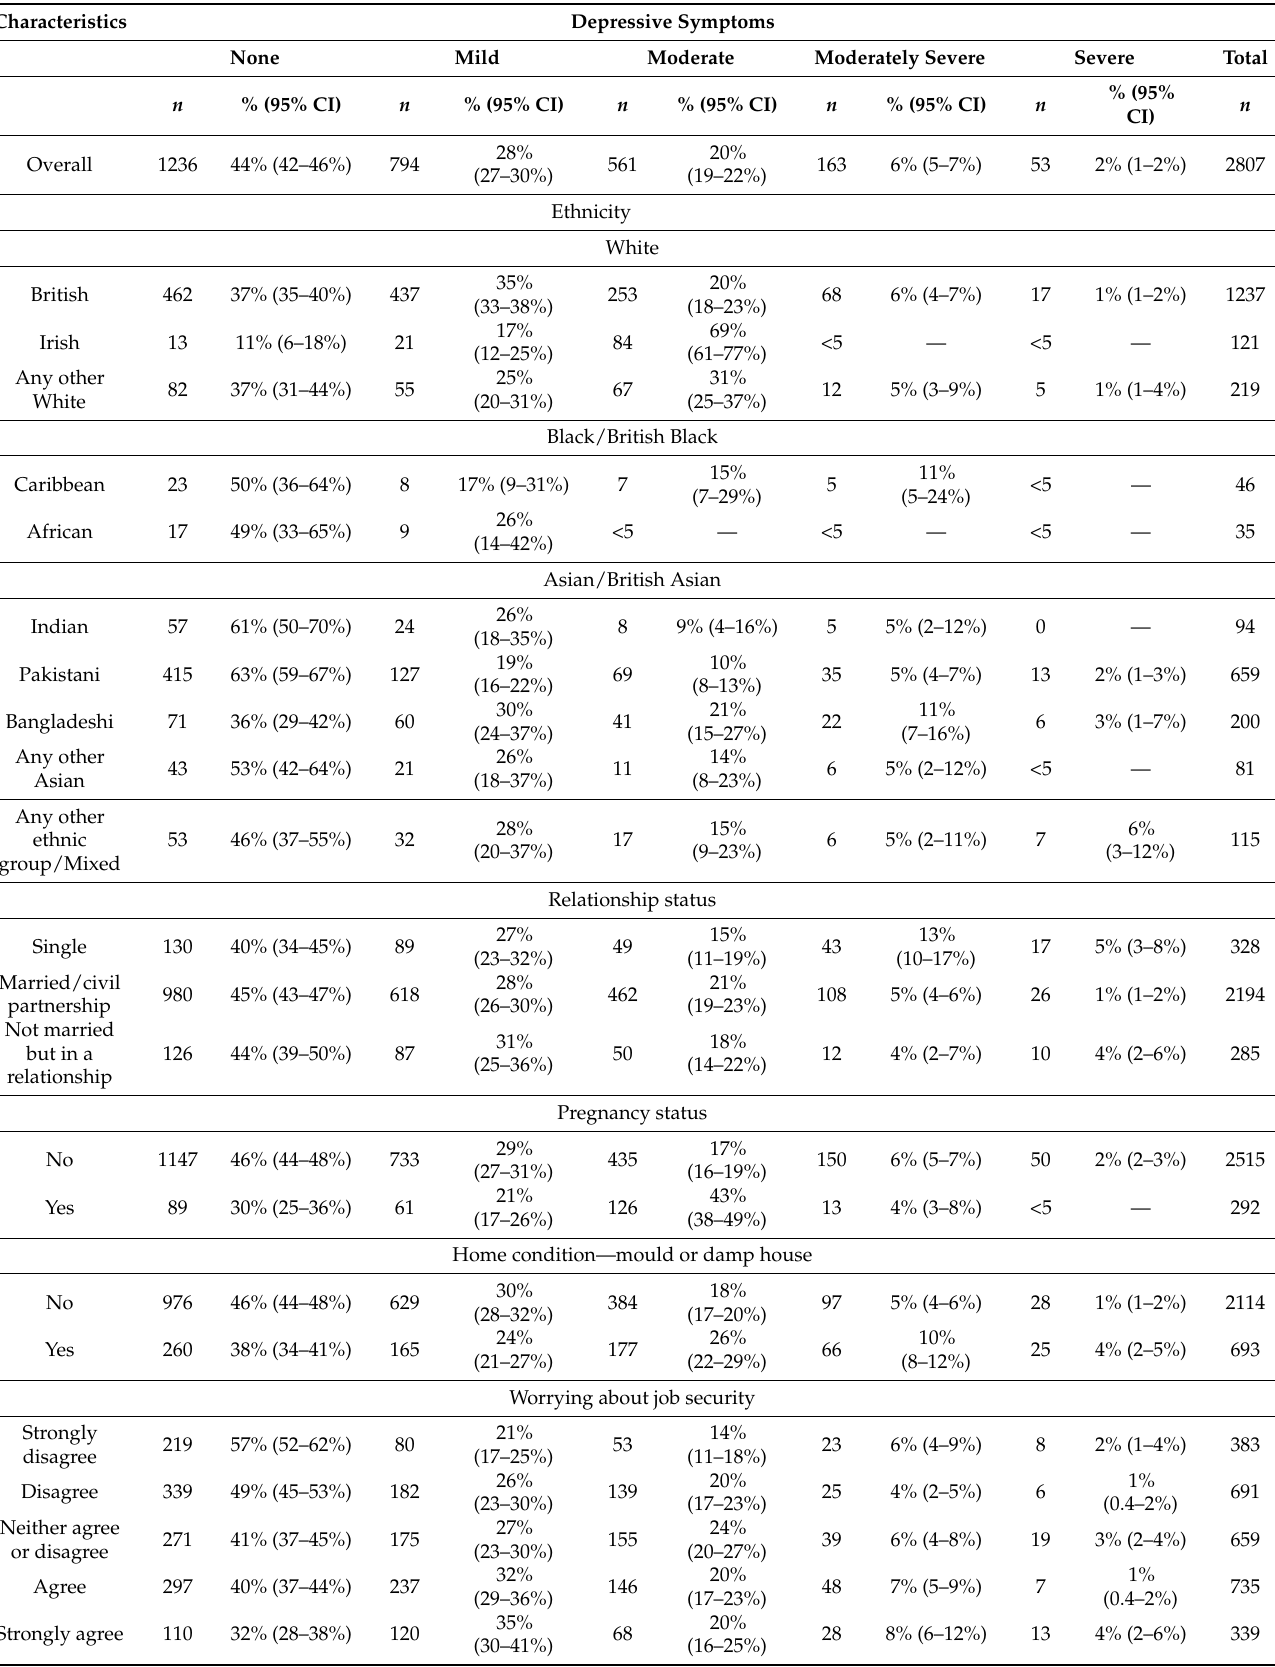
Table 2. Differences in maternal and home characteristics by levels of depressive symptoms ( n =